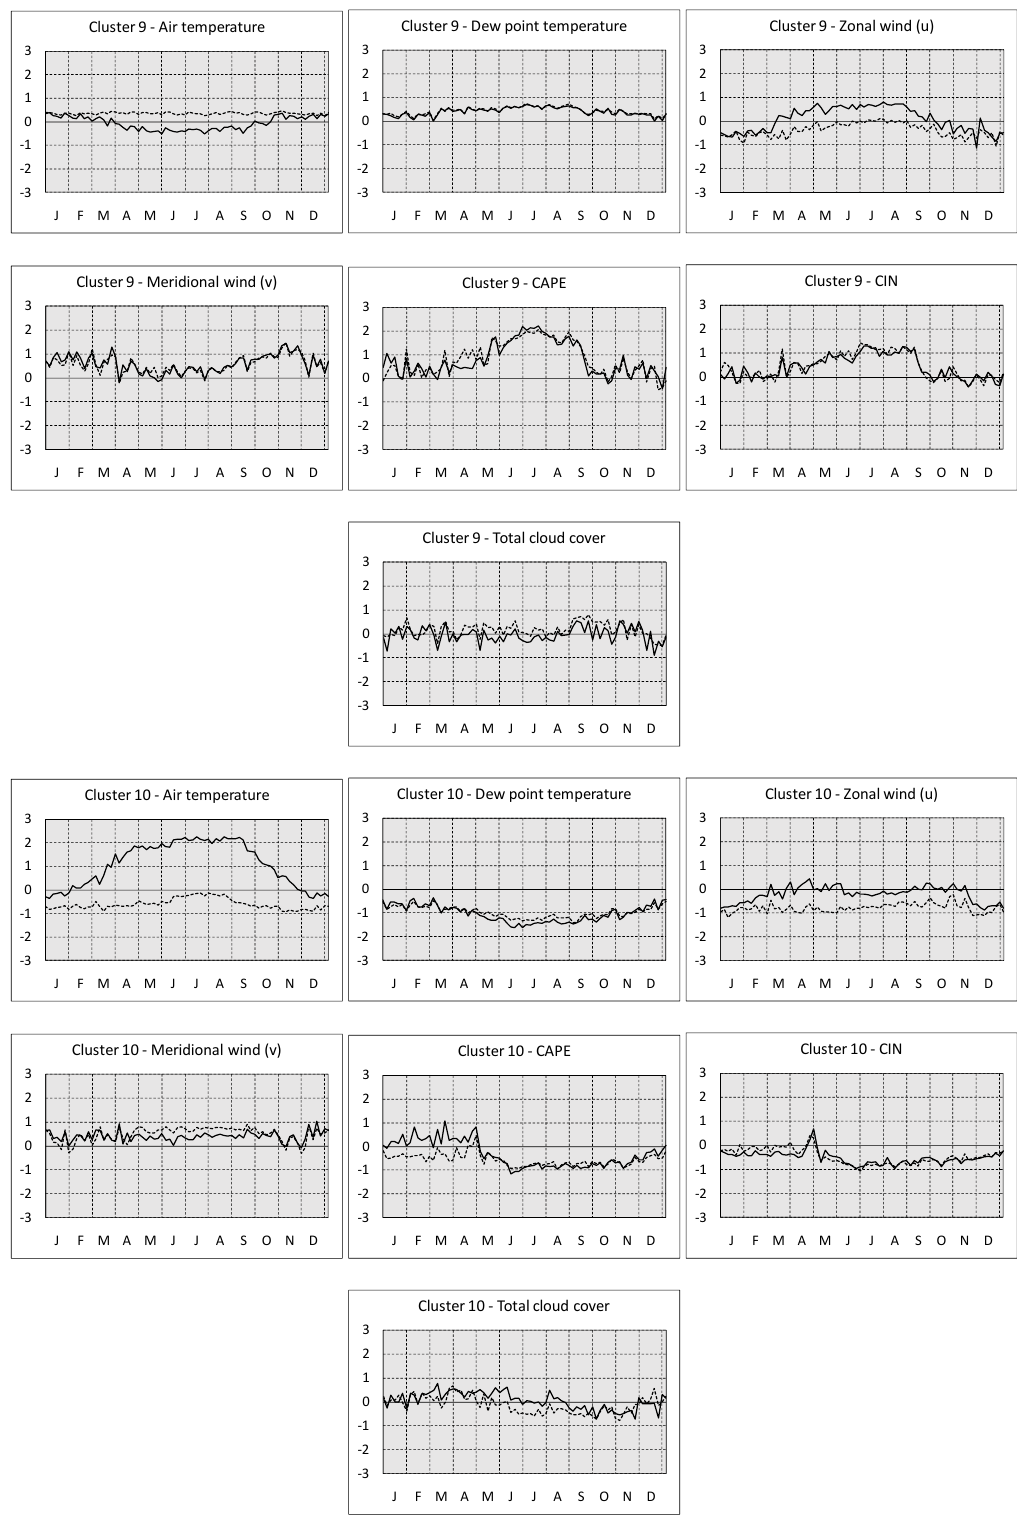
Figure 8. As in Figure 4, but for clusters 9 and 10.